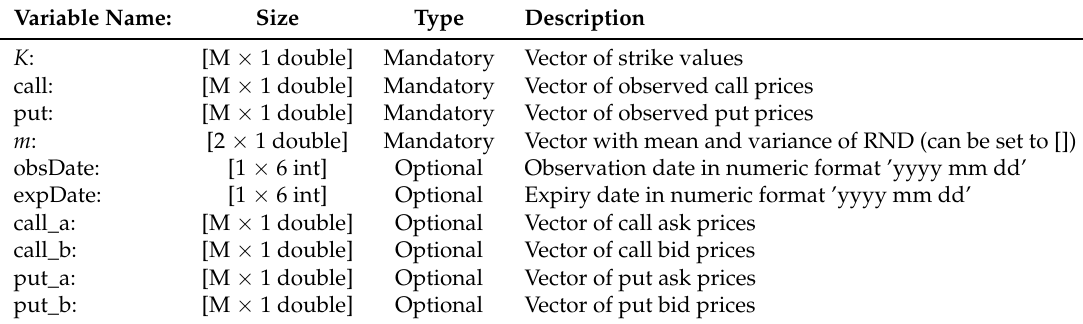
Table 1. Format of the input